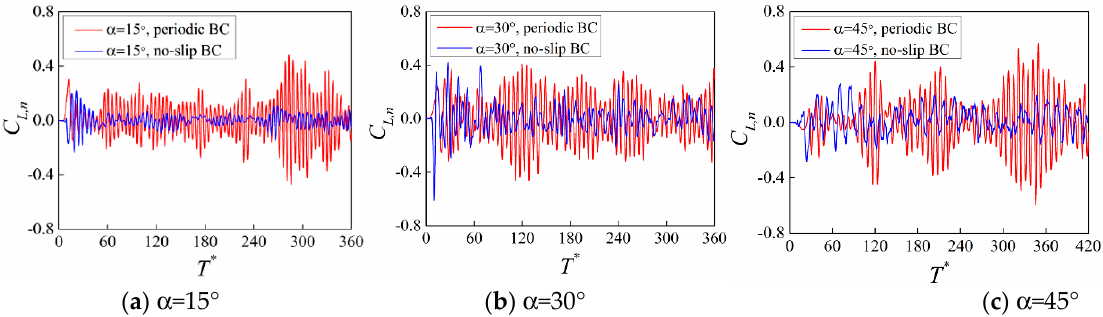
Figure 13. Time histories of lift coefficient for nonslip boundary condition and periodic boundary